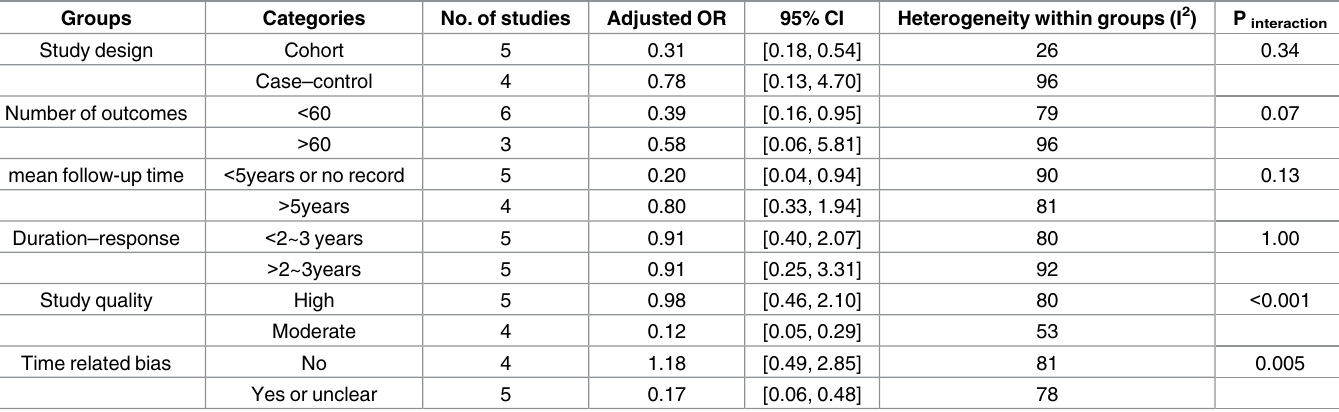
Table 3. Subgroup analyses and duration–response relationship on the association of PPIs use and risk of EAC and/or HGD in patients with